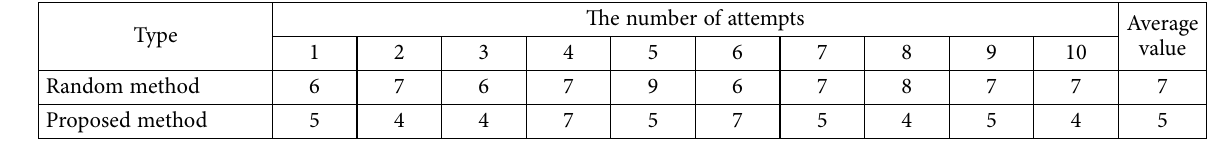
Table 3. Minimal number of vehicles